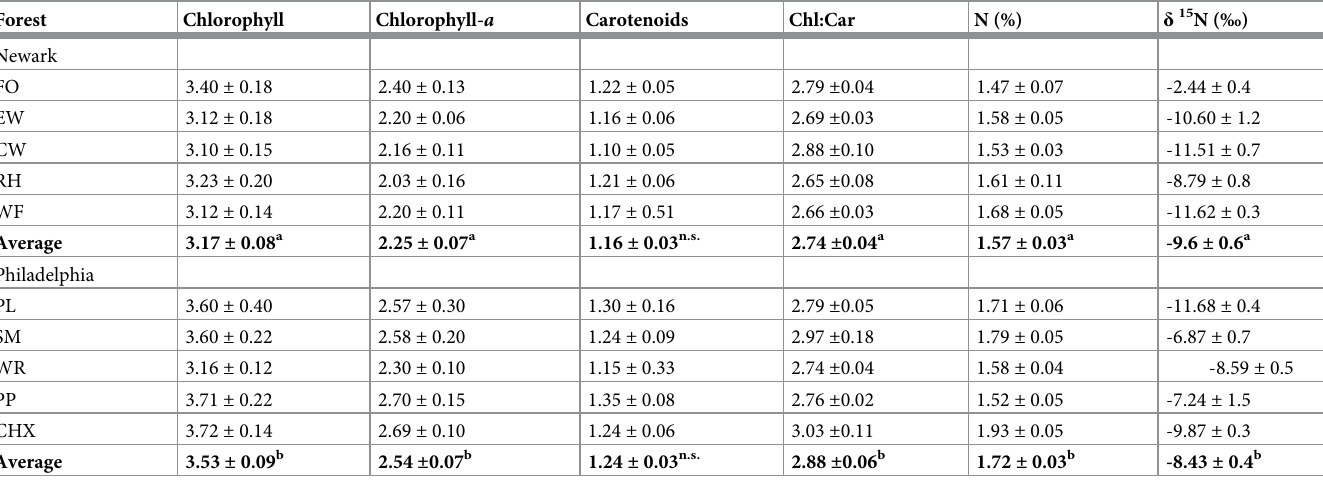
Table 1. Total chlorophyll, chlorophyll- a , carotenoids, chlorophyll:carotenoid (Chl:Car) ratio, N content, and natural abundance δ 15 N for red maple trees in five forests each in Newark, DE (n = 39) and Philadelphia, PA (n = 38). Forest Chlorophyll Chlorophyll- a